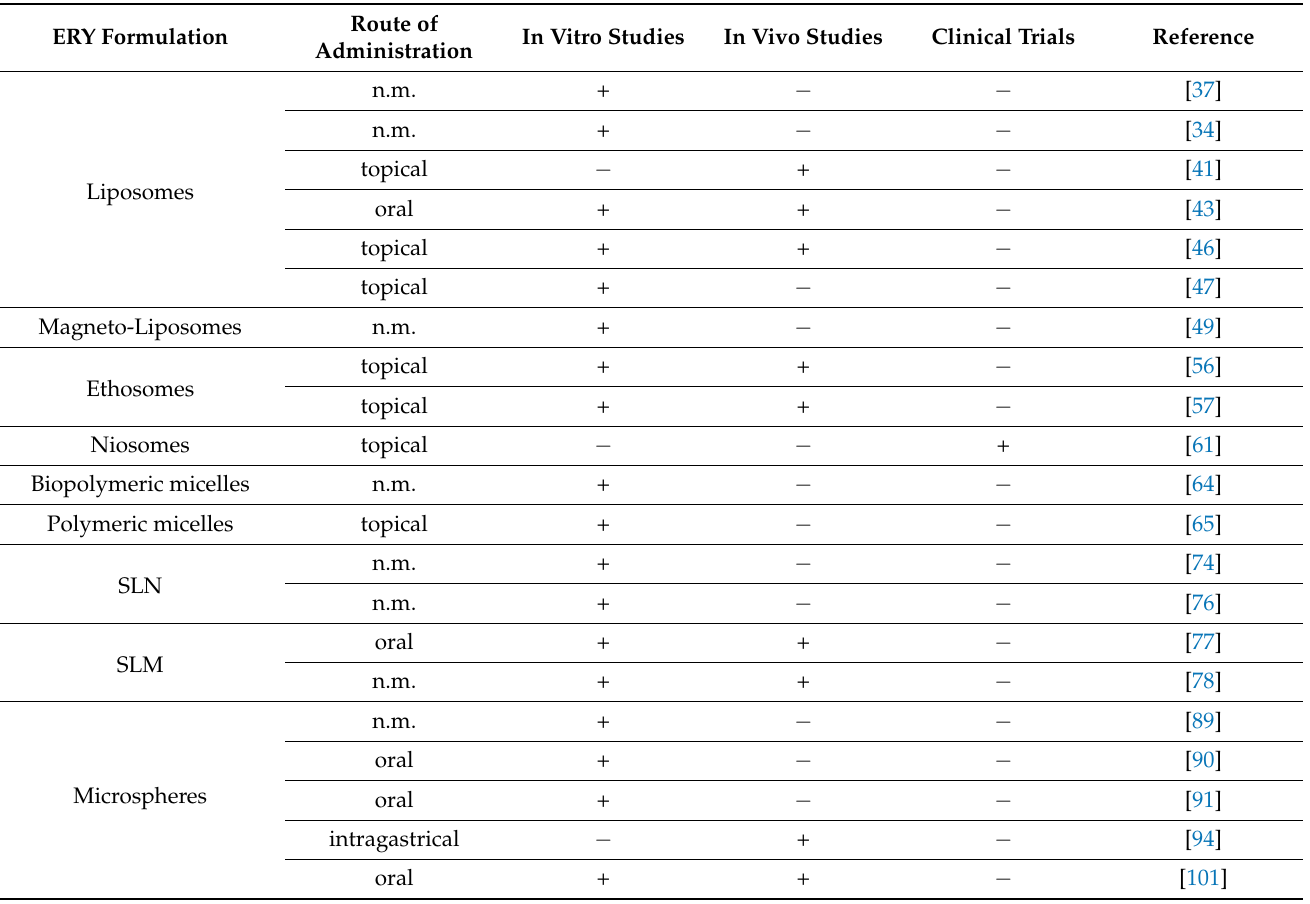
Table 1. Summary of the stage of investigation of ERY formulations. ERY